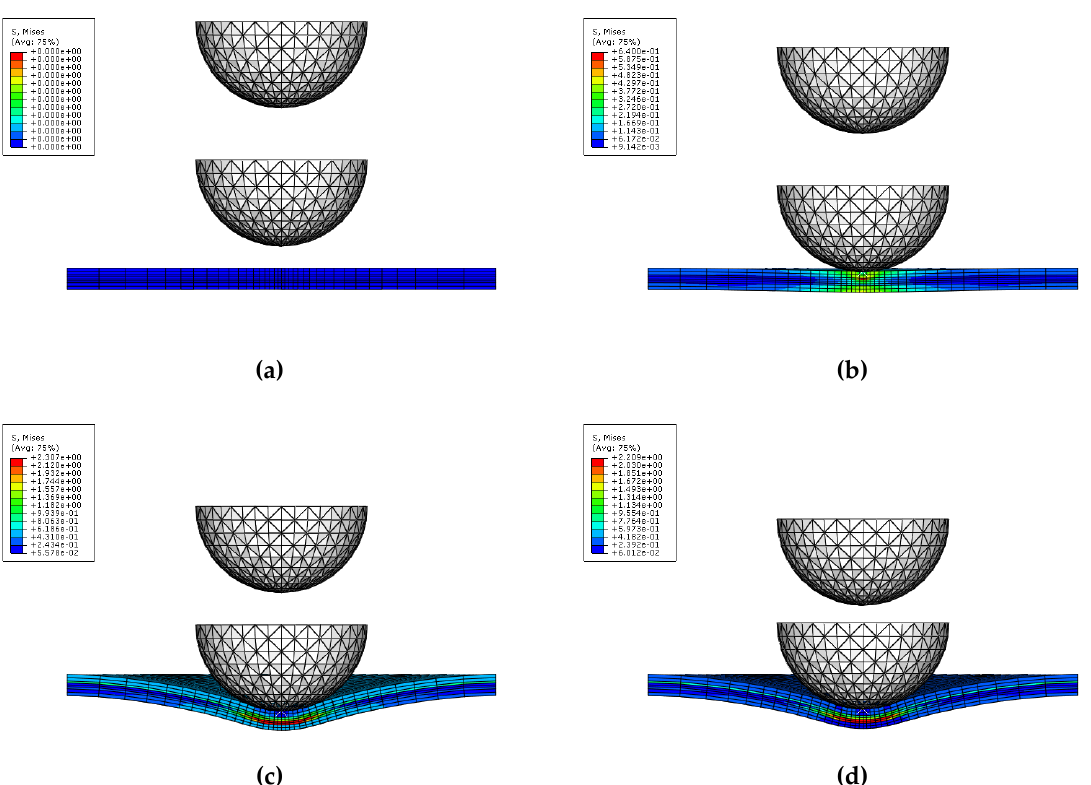
Materials 2021 , 14 , x FOR PEER REVIEW Figure 11. First impact applied on GLARE 5-2/1: ( a ) Time = 0 ms, ( b ) Time = 0.26 ms, ( c ) Time = 3.53 ms, ( d ) Time = 5.62 ms.